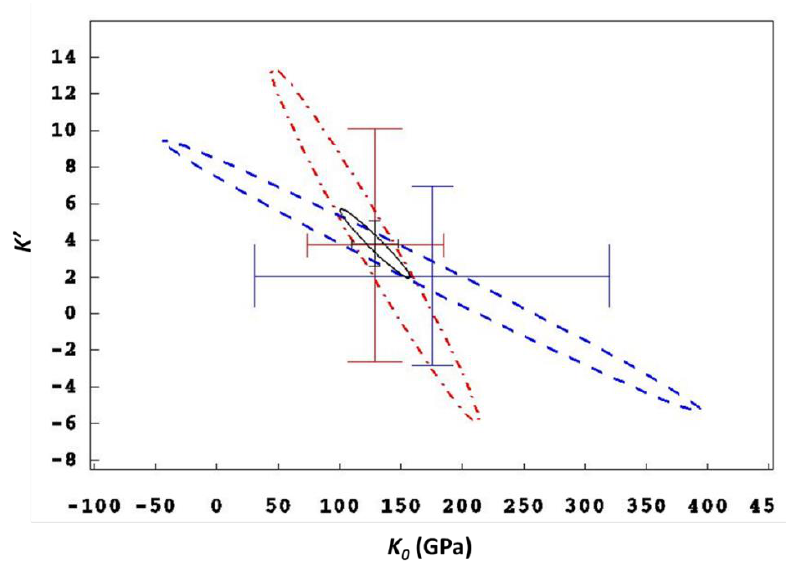
Figure 8. Confidence ellipses in K 0 and K ′ for the fitting of volume-pressure data below 16 GPa (dot- dashed red line), above 16 GPa (dashed blue line), and the entire pressure range up to 32 GPa (solid black line). Crosses indicate the center of each ellipse.